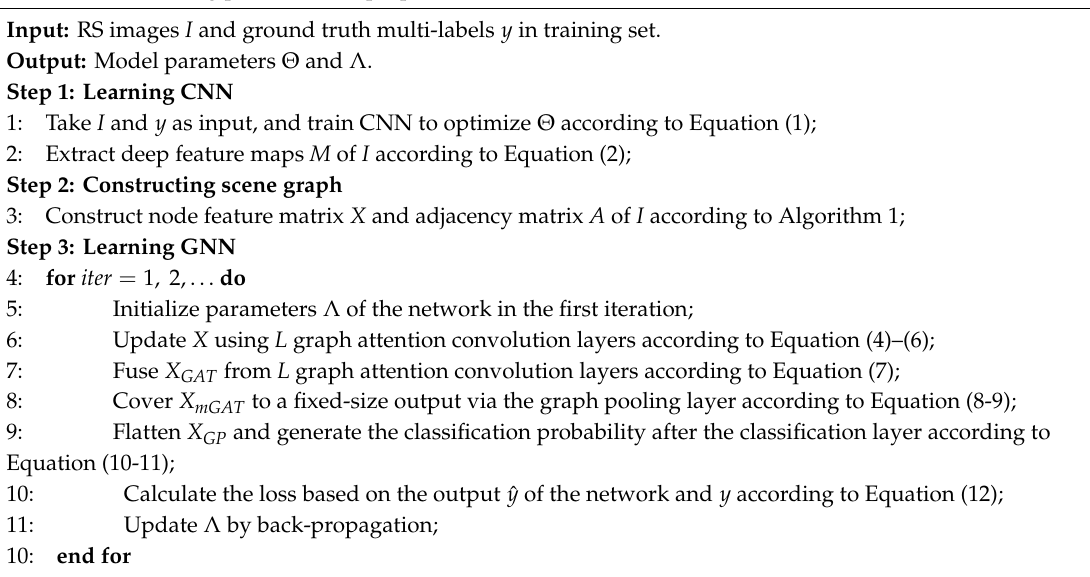
Algorithm 2 Training process of the proposed MLRSSC-CNN-GNN framework